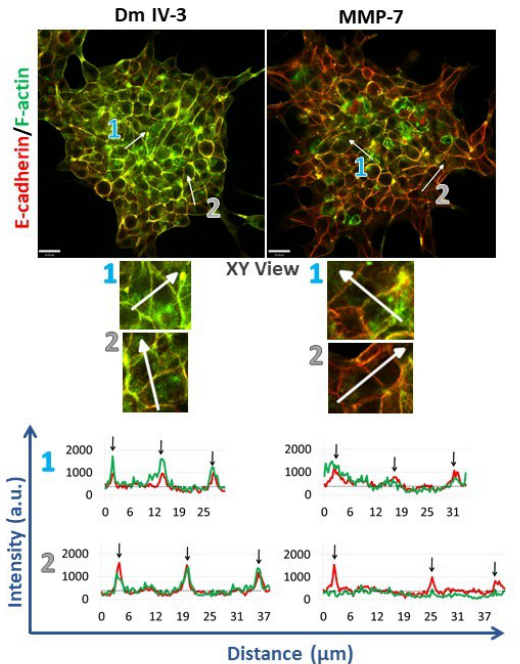
Figure 6. Immunostained microtumors for E-cadherin (red) and F-actin (green) at 24 h. Line scan analyses (see text) were performed for the regions highlighted by the white arrows. Arrow 1: microtumor center, arrow 2: microtumor periphery. Dm IV-3-treated microtumors show increase in co-aligned E-cadherin (red line) and F-actin (green line) at cell–cell contacts (black arrows) whereas microtumors treated with MMP-7 show a decrease in E-cadherin and F-actin co-alignment, indicative of loss of adhesion and initiation of cell dispersion. Line scans were performed on multiple cell–cell boundaries in microtumors under a variety of cohesive and dispersing conditions, then Pearson’s correlation analysis was performed on the same clusters at high magnification (3 clusters/condition). The images shown are representative of what we observed. Scale bars: 30 µm .